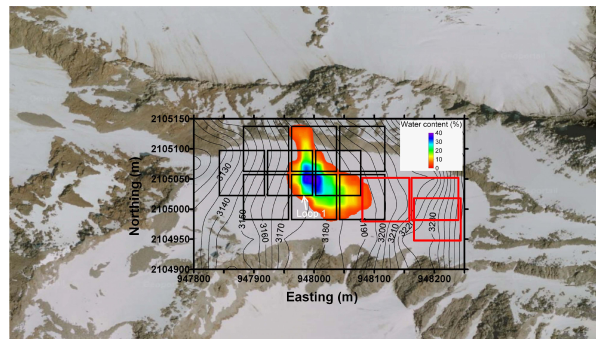
Fig. 2. Aerial photo of the Tête Rousse glacier with an approxi- mate projection of the SNMR measuring loops (black squares) and water-filled cavern detected in 2009 (in the Lambert-II co-ordinate system). Additional SNMR loops used in 2012 are shown as red squares. Isoclines show the elevation of the glacier surface in